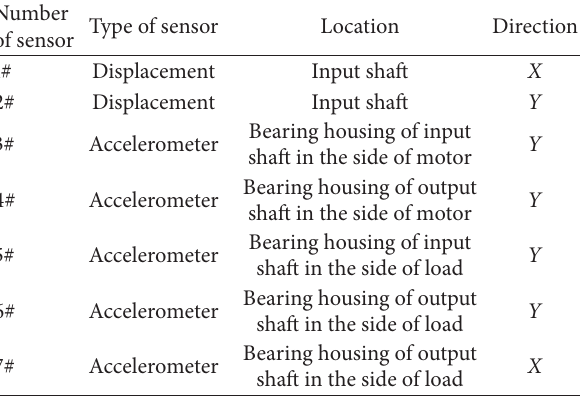
Table 1: Specific information of seven